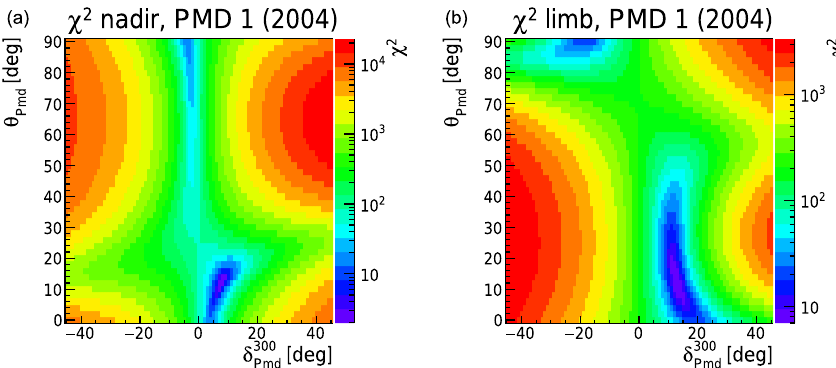
Figure 13. χ 2 distribution according to Eq. (30) for PMD 1, nadir (a) and limb (b) in 2004. The retardance parameter is on the x axis and the retarder angle on the y axis; the color code depicts χ 2 on a logarithmic (rainbow) color